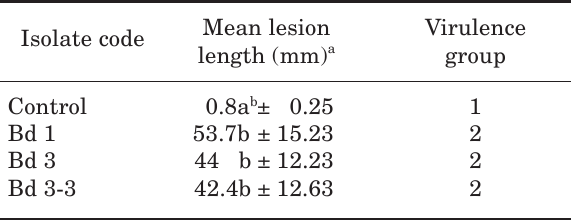
Table 4. Pathogenicity of Botryosphaeria dothidea on 1- year-old canes of Cabernet Sauvignon.